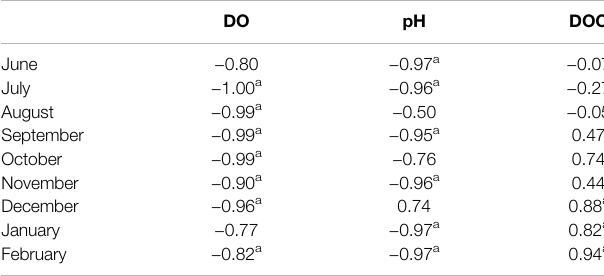
TABLE 1 | The monthly values of Pearson correlation coef fi cient (r) of pCO 2 with water quality variables in the headwater stream at sites A — F. DO pH DOC −